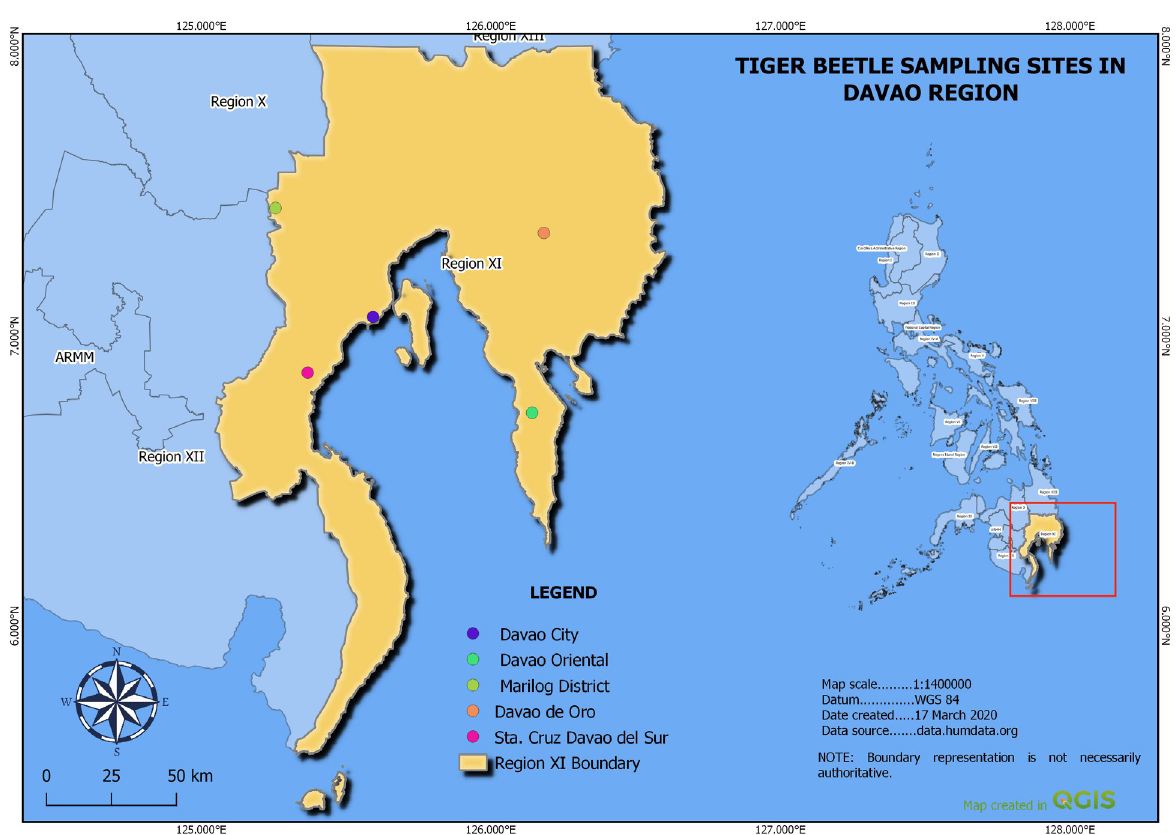
Figure 1. Sampling sites in Davao